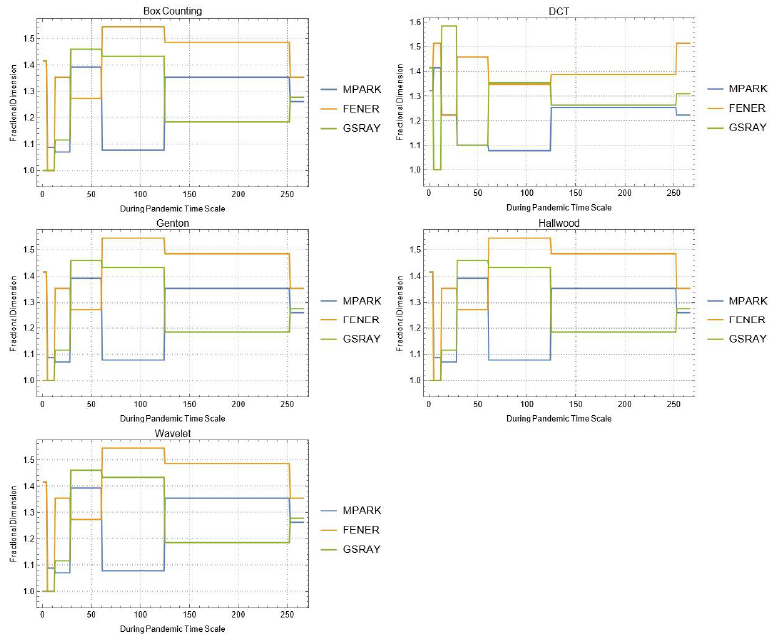
Figure A1. Daily changes of fractal dimensions during the pandemic (social).